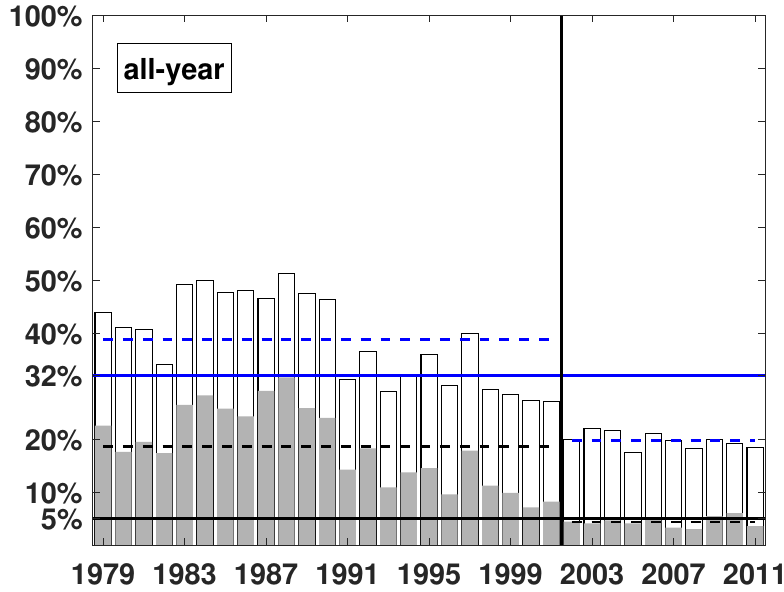
Figure 11. Percentage of days for which the errors of sDoG exceed 1SE (white bars) and 2SE (grey bars). The black vertical line marks the end of the true evaluation period (1979 to 2001) and the beginning of the cross-validation period (2002 to 2012). Following the definition of 1SE and 2SE as 68% and 95% confidence intervals of sDoG, the white bars should on average not exceed 32% of the data (blue, upper solid line), and the grey bars should on average not exceed 5% of the data (black, lower solid line). The average of the white (grey) bars is indicated by the blue (black) dashed line individually for the true evaluation period and the training period, respectively. If the dashed lines are higher than the solid lines in the true evaluation period, this means that the cross-validation-based uncertainty estimates 1SE and 2SE underestimate the true uncertainties of